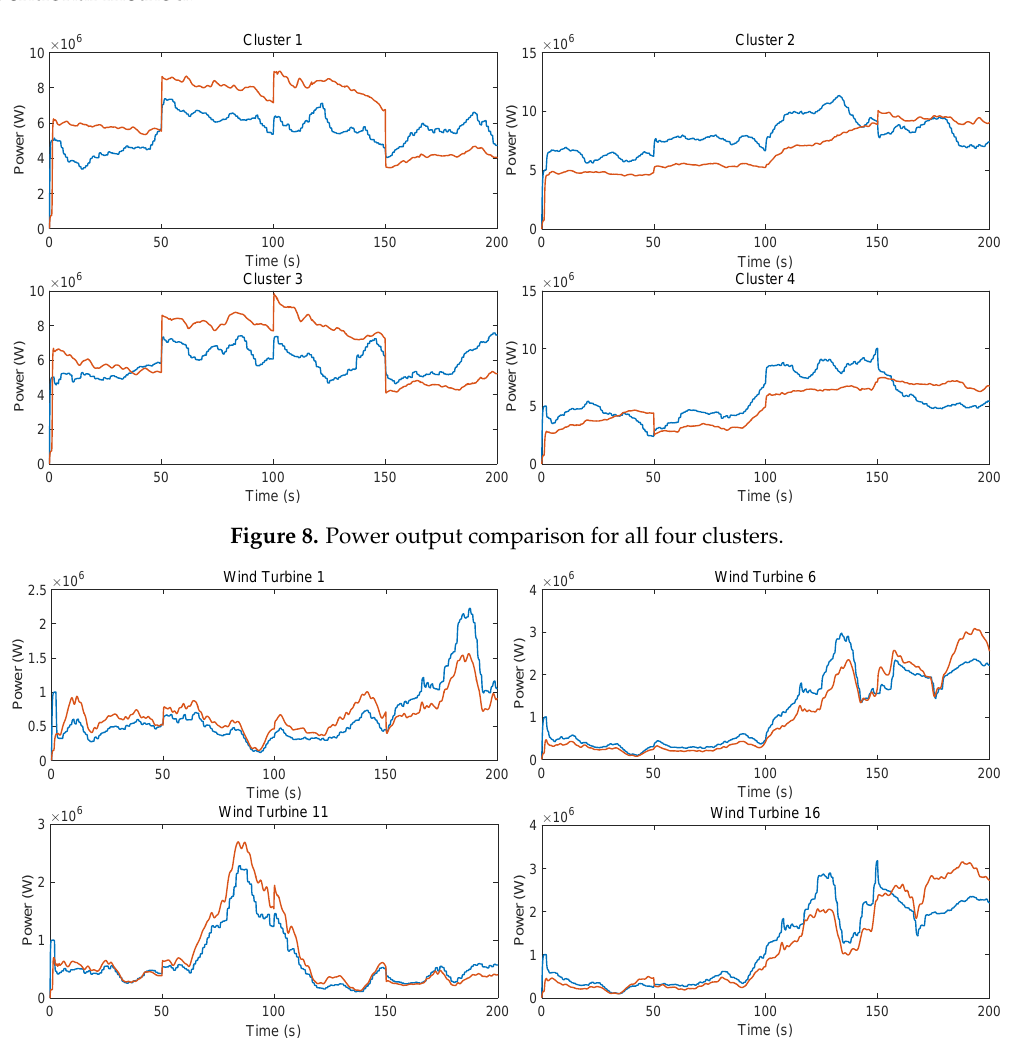
Figure 9. Power output comparison for wind turbines 1, 6, 11, and